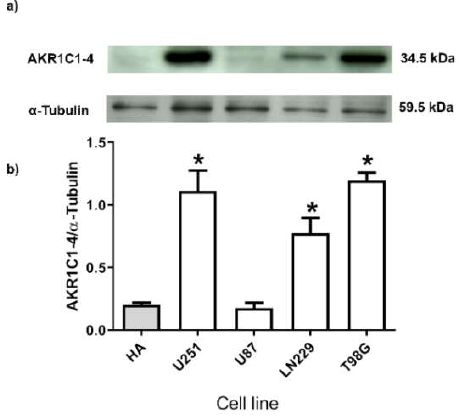
Figure 3. AKR1C1-4 are differentially expressed in GB cells. The expression of AKR1C1-4 was detected in a total protein extract from normal human astrocytes (HA) and different human GB cell lines. ( a ) Representative Western blots of AKR1C1-4 and α-Tubulin, which was used as a loading control. ( b ) Densitometric analysis graph. Each column represents the mean ± SEM. n = 3; * p < 0.05 U251, T98G, and LN229 vs. HA and U87 cell lines.